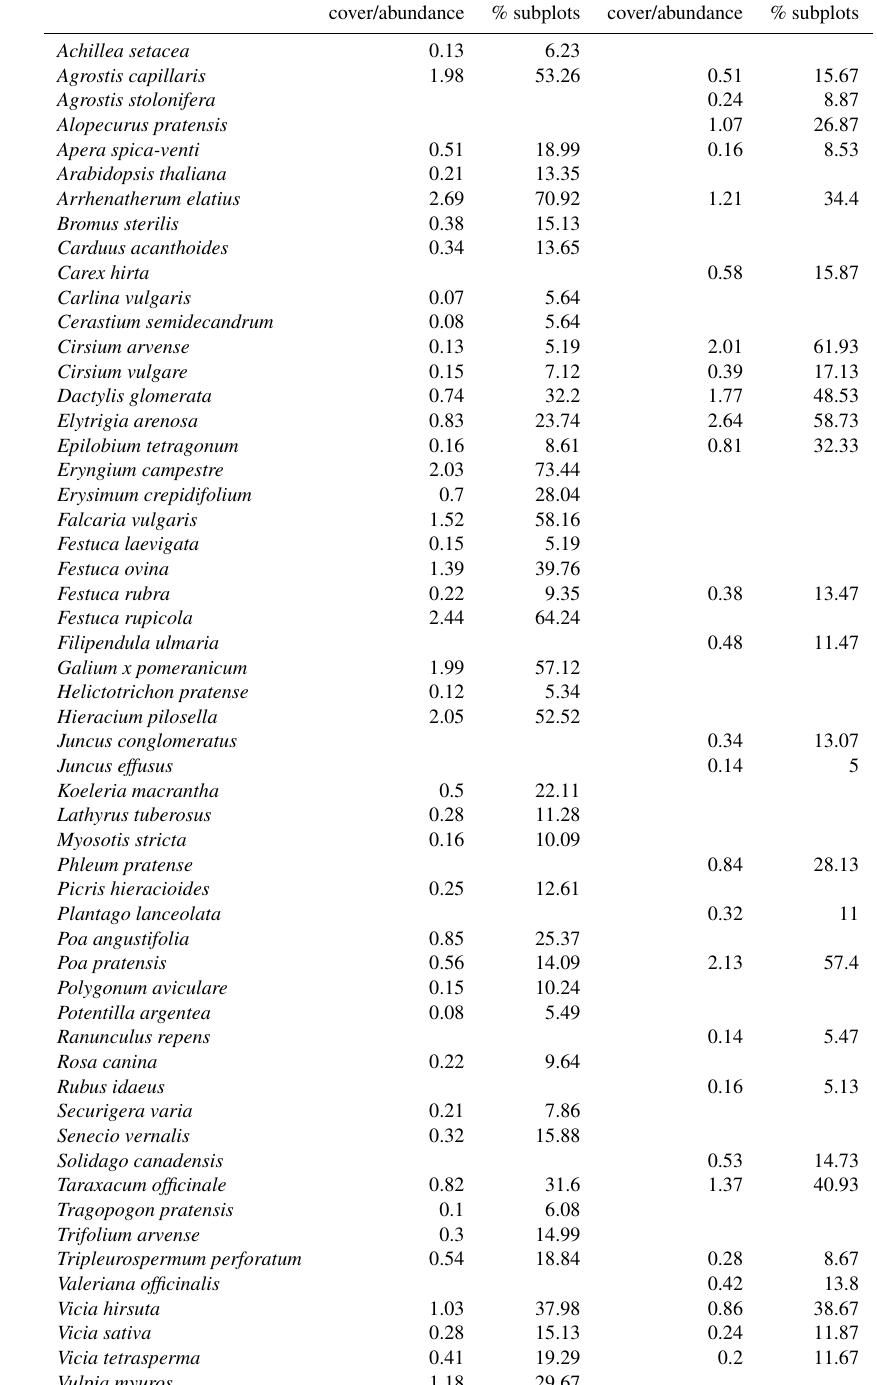
Table A1. List of the more common species (species that occurred in at least 5% of all subplots of one site) recorded across all subplots and years in Gimritz as well as in Bayreuth. Furthermore, we list for these species the mean of the recoded Braun-Blanquet values (see Material and methods) for the subplots. The species names follow Biolflor